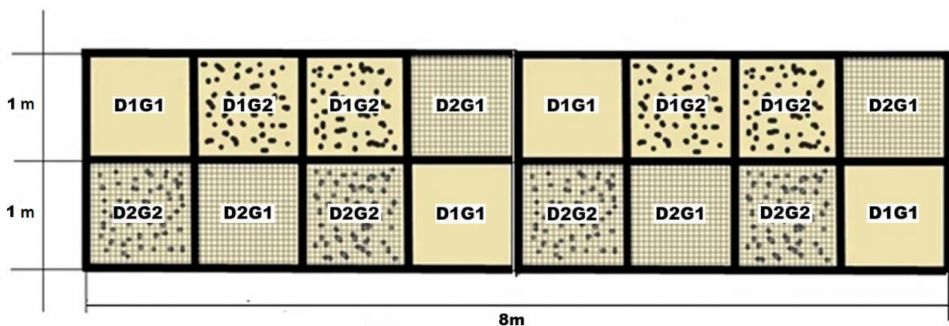
Figure 1. Organization of boxes distributed based on the top cushion material which consists of sand (G1) or sand with geotextile (G2) over limestone (D1) or over a drainage package (D2) along with combinations of both treatments (D1G1, D1G2, D2G1, D2G2).